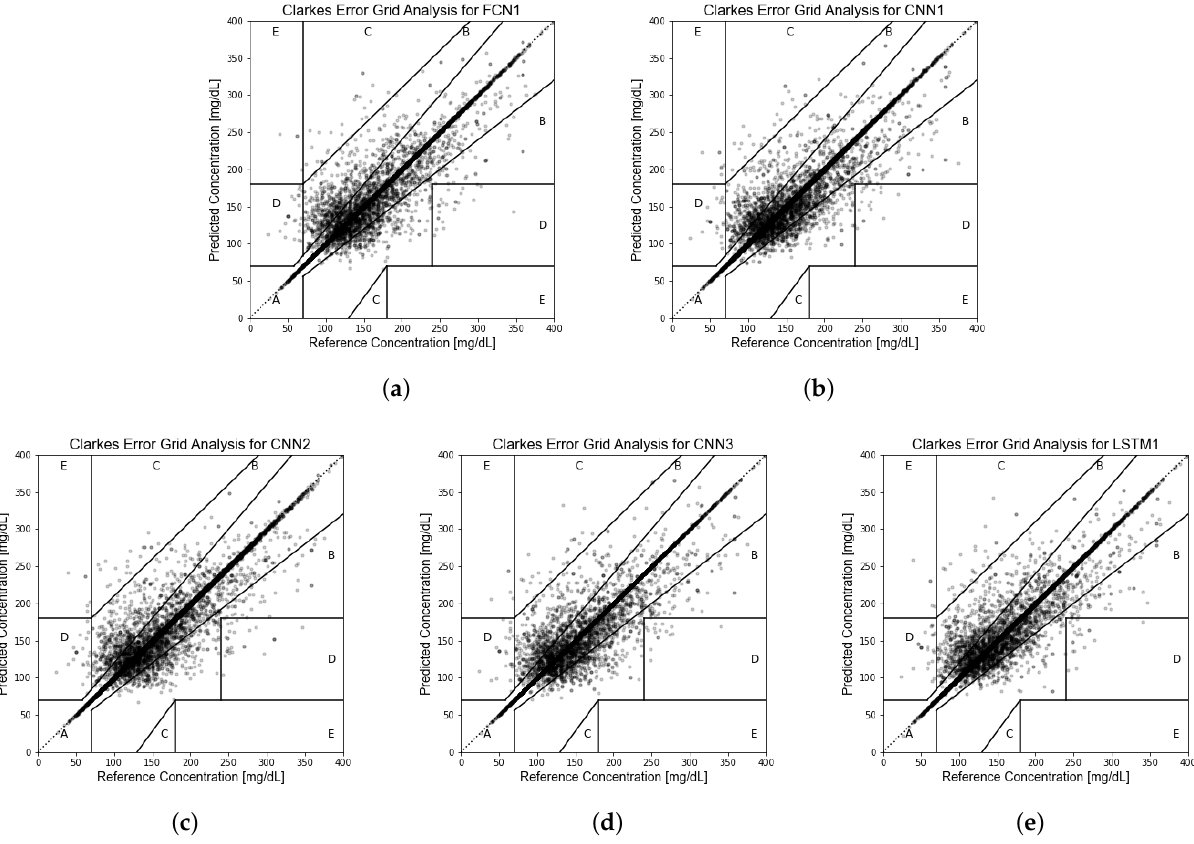
Figure 4. ( a ) Clarke Error Grid Analysis of model FCN1. ( b ) Clarke Error Grid Analysis of model CNN1. ( c ) Clarke Error Grid Analysis of model CNN2. ( d ) Clarke Error Grid Analysis of model CNN3. ( e ) Clarke Error Grid Analysis of model